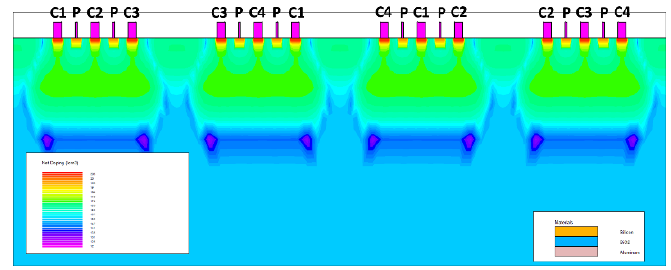
Table 1. The offset voltages and voltage sensitivity of the double three-contact structure.